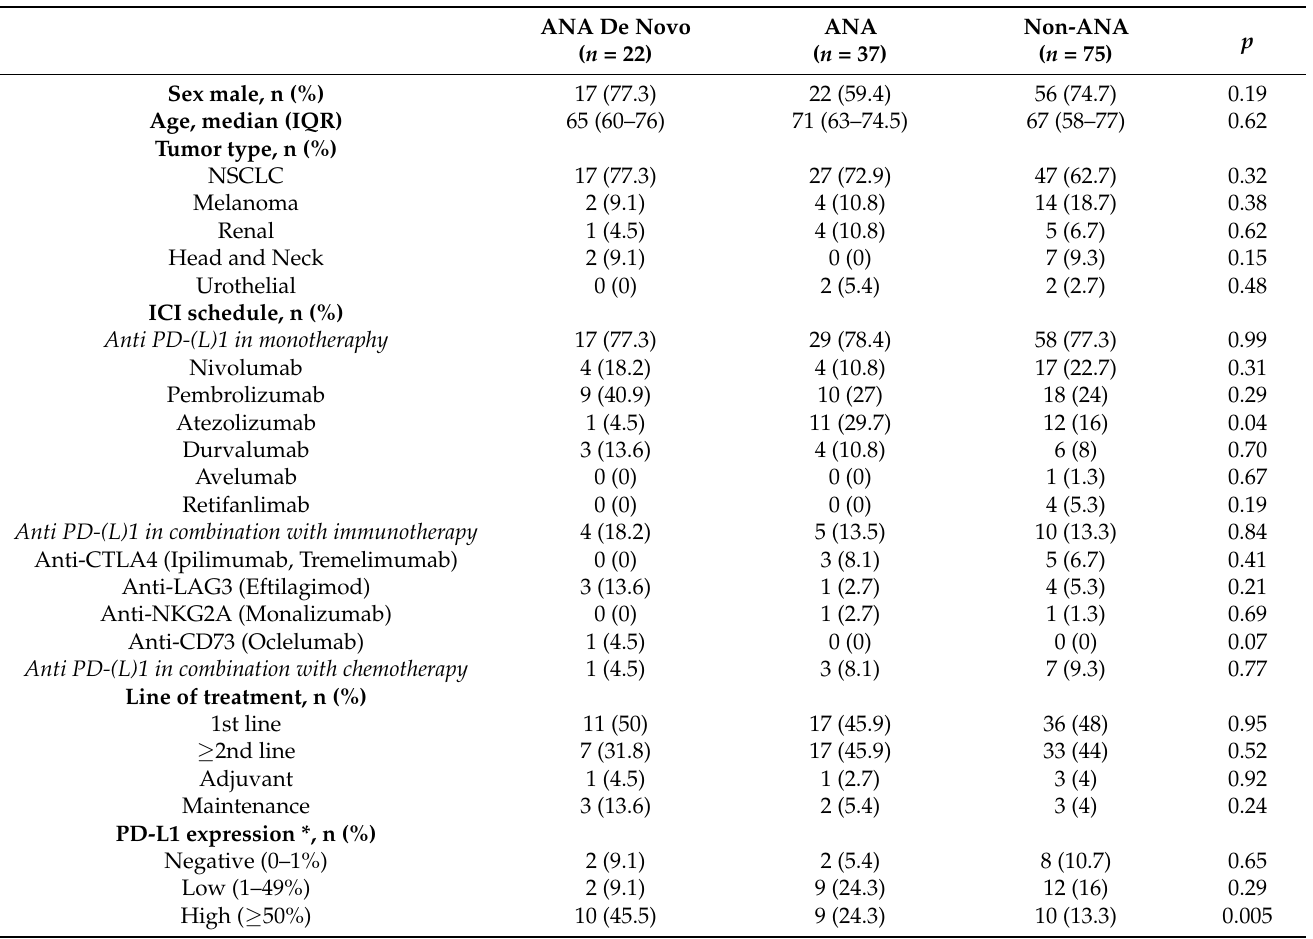
Table 1. Patient characteristics and ICI treatment comparison in patients grouped according to the presence of ANA during